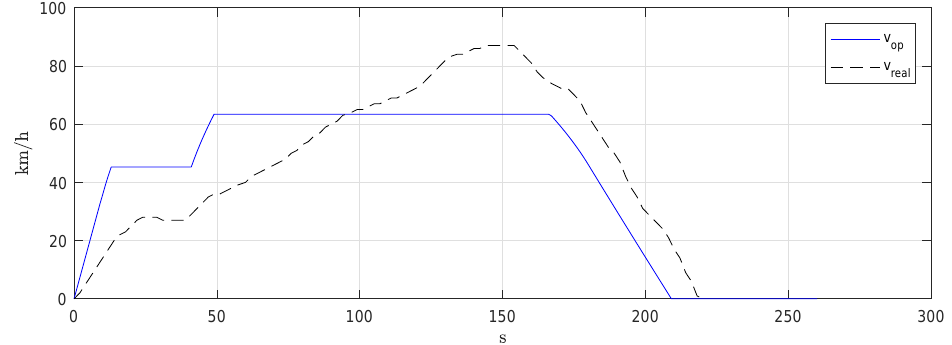
Figure 14. Case C—Actual (dashed black) and proposed (solid blue) speed